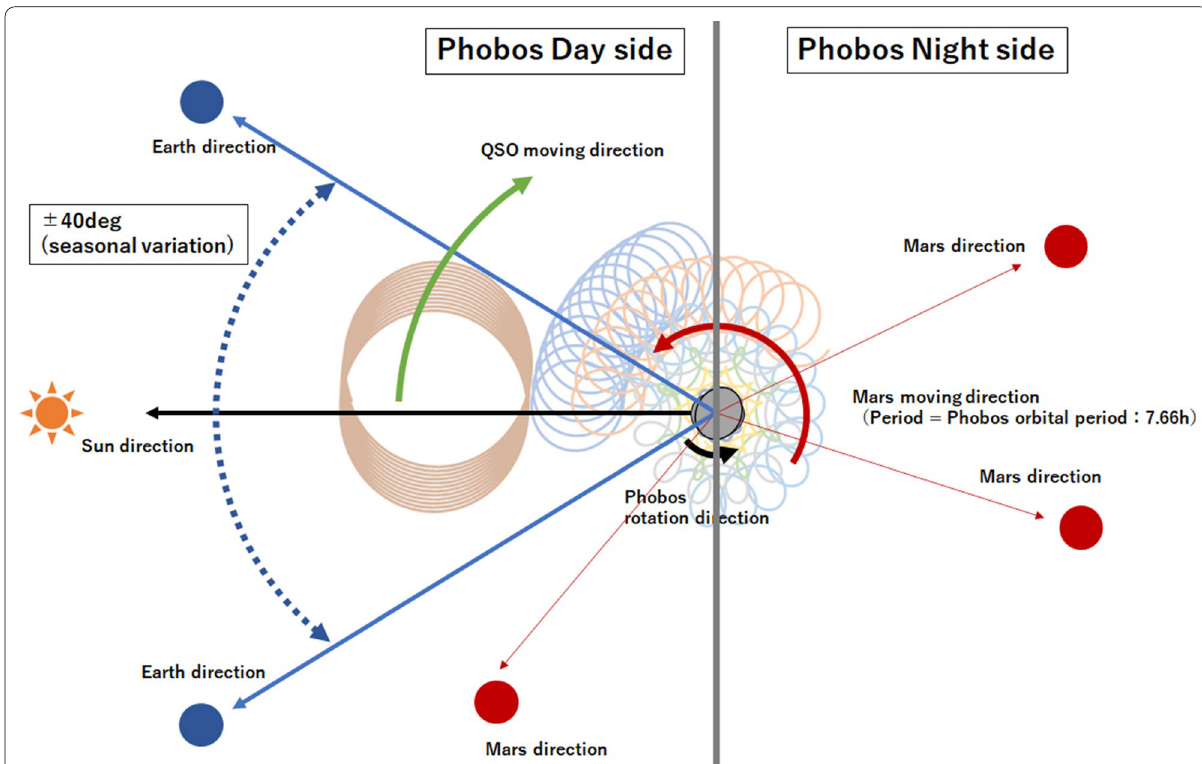
Fig. 5 The position of the spacecraft, Sun, Earth (blue), and Mars (red) in an inertial coordinate system centered on Phobos. QSOs corresponds to those in Fig. 3. Phobos‑Sun direction is fixed